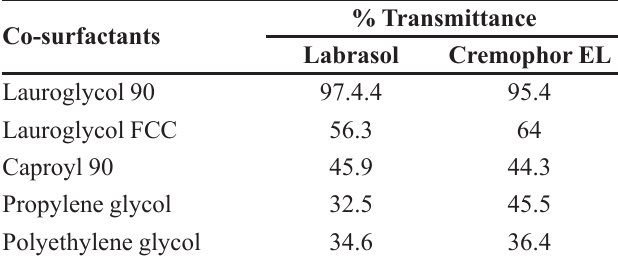
TABLE II - Emulsification efficiency of various cosurfactants using surfactant labrasol and Cremophor EL and oily phases (LBF M 2125 CS + Maisine 35-1 (1:1)